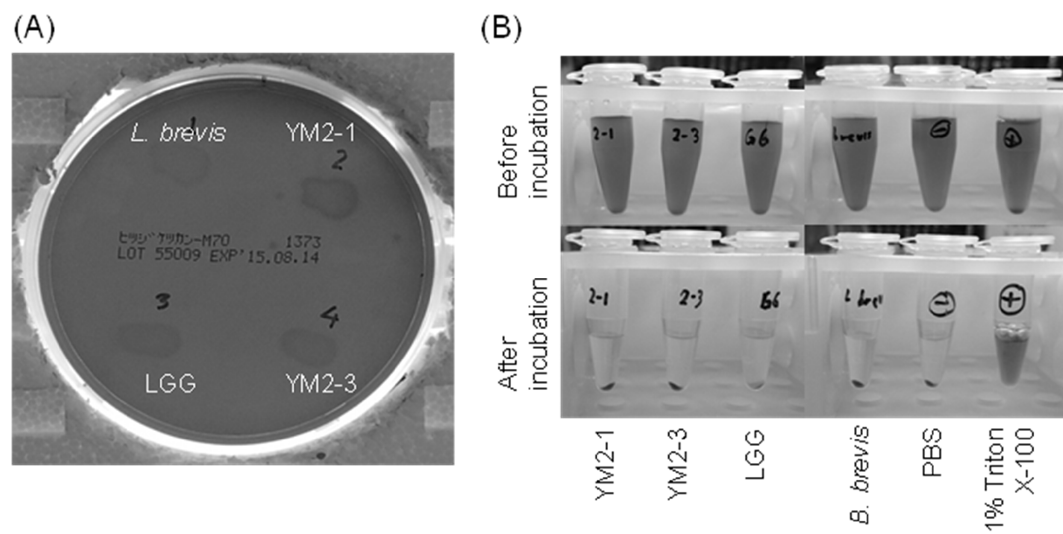
Figure 6. Hemolytic activities of YM2-1 and YM2-3 strains investigated ( A ) on 5% sheep blood agar plates and ( B ) in vitro against RBCs prepared from defibrinated sheep blood. The 1% ( v / v ) Triton X-100 was used as a positive control. Levilactobacillus brevis ATCC 8287 and PBS were used as negative controls.